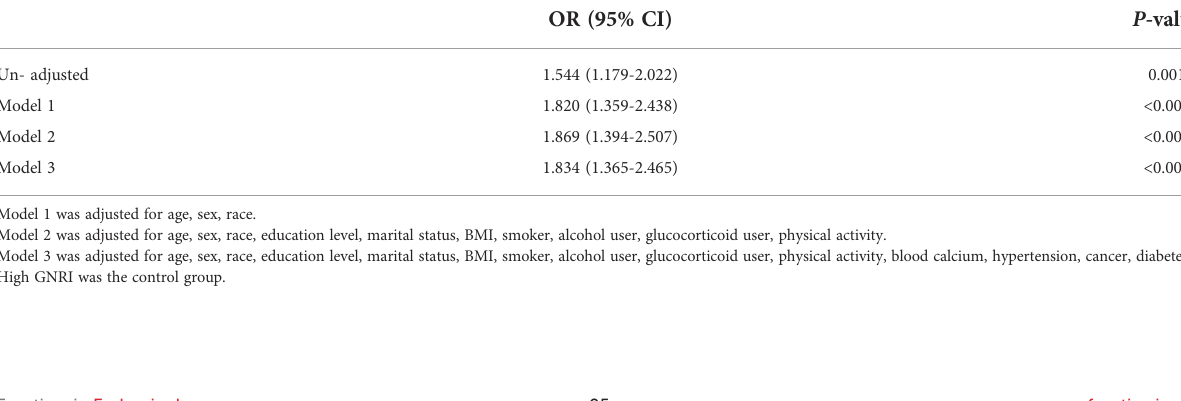
TABLE 2 Logistic regression analysis for associations between Low-GNRI and osteoporosis.